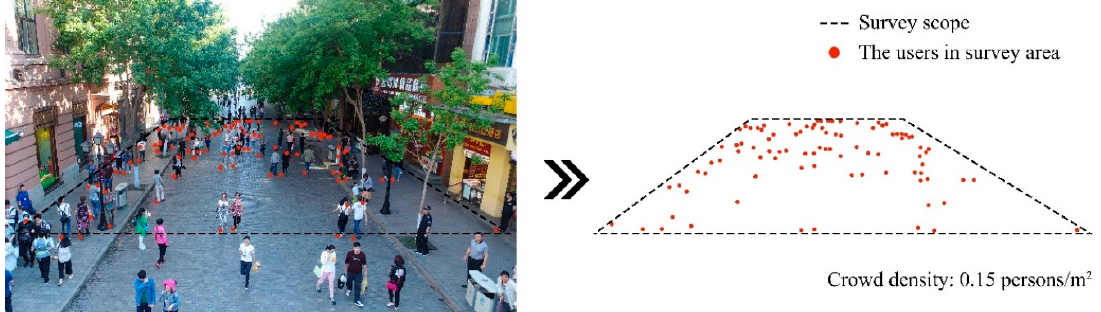
Figure 3. The crowd density measurement.